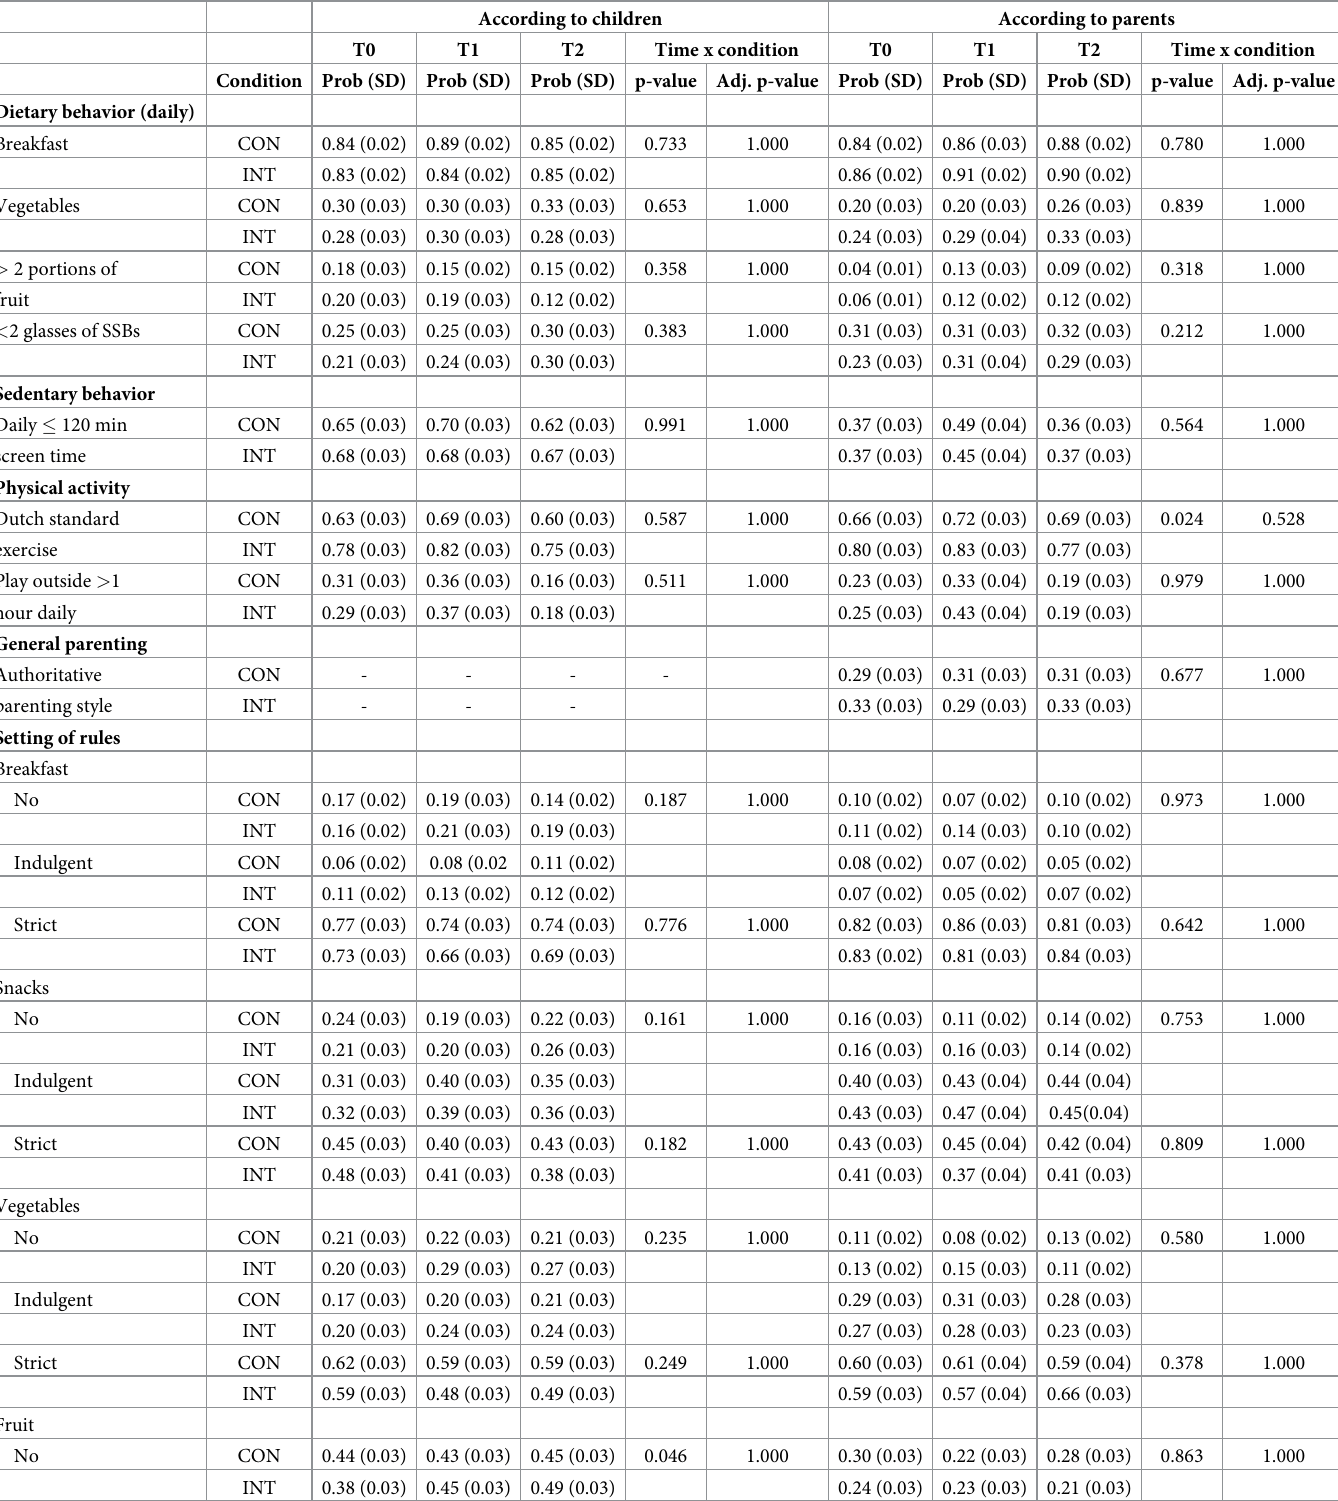
Table 4. Observed probabilities per condition and measurement point and time by condition interactions for dichotomized